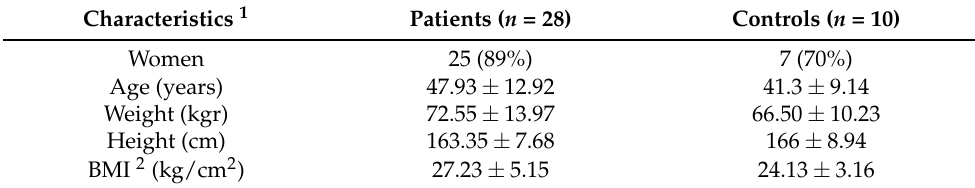
Table 1. Characteristics of the study